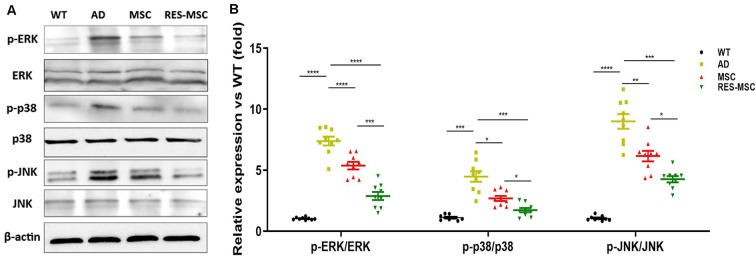
MSCs and RES-MSCs regulated MAPK signaling in the hippocampus of AD mice. (A) Representative images of Western blotting of p38, JNK, ERK, and phosphorylated p38, JNK, and ERK. (B) Relative expression of p-p38/total p38, p-JNK/total JNK, and p-ERK/total ERK in mice hippocampus. Analysis of the gray values from Western blotting obtained for three mice from each group and from three independent experiments from each mouse (n = 9). Results were expressed as mean ± SEM. *p < 0.05, **p < 0.01, ***p < 0.001, ****p < 0.0001 (ANOVA plus Bonferroni: p-p38/p38: WT vs. AD p < 0.0001, MSC vs. AD p = 0.0043, RES-MSC vs. AD p < 0.0001, MSC vs. RES-MSC p = 0.0003. p-JNK/JNK: WT vs. AD p = 0.0002, MSC vs. AD p = 0.0171, RES-MSC vs. AD p = 0.0007, MSC vs. RES-MSC p = 0.0186. p-ERK/ERK: WT vs. AD p < 0.0001, MSC vs. AD p = 0.0097, RES-MSC vs. AD p = 0.0001, MSC vs. RES-MSC p = 0.0135).